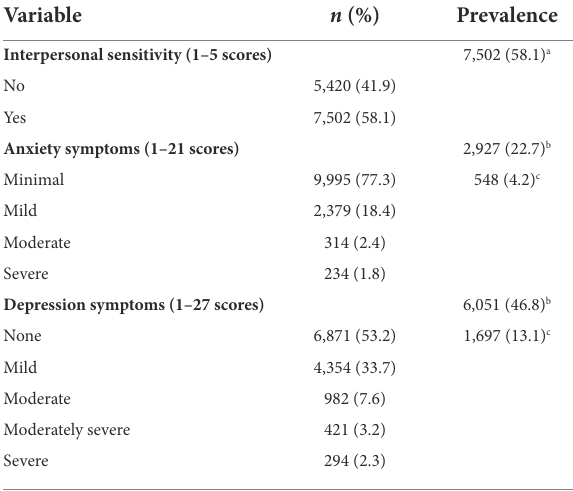
TABLE 1 Overall scores and prevalence of interpersonal sensitivity, anxiety symptoms and depression symptoms [ n (%)].